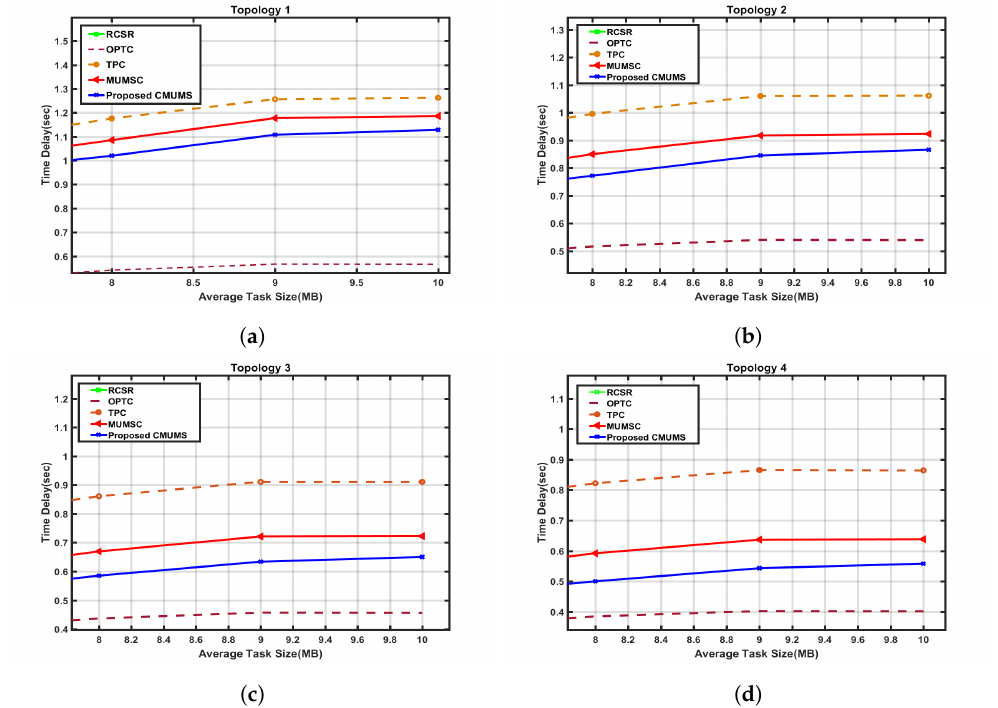
Figure 7. Cross-section of Time Delay vs. Average Task Size in four topology structure. ( a ) Time delay vs. Average task in 1st topology; ( b ) Time delay vs. Average task in 2nd topology; ( c ) Time delay vs. Average task in 3rd topology; ( d ) Time delay vs. Average task in 4th